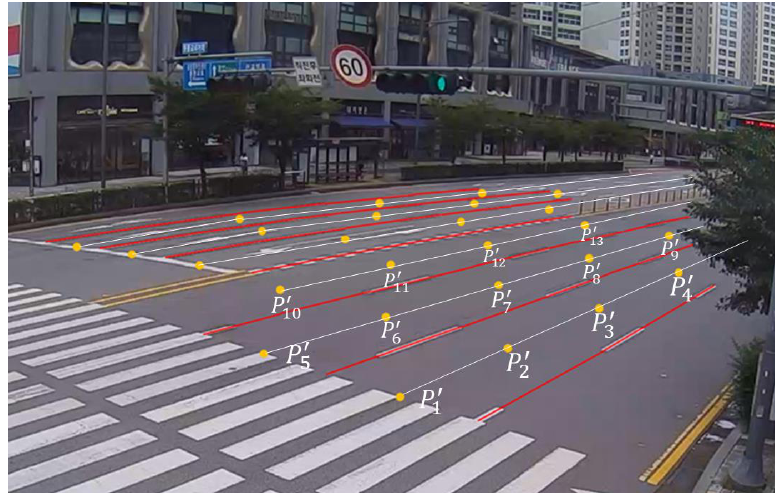
Figure 9. Definition of error estimation for the world coordinate.